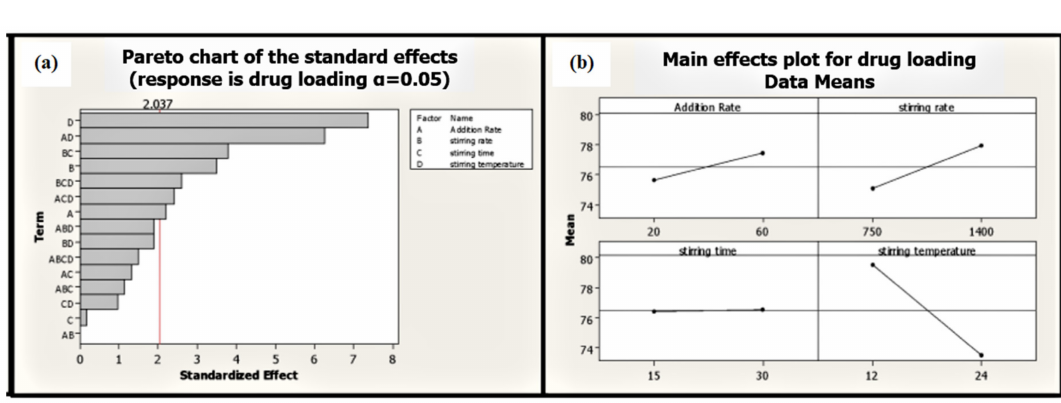
Figure 7. Pareto ( a ) and main e ff ect plot ( b ) of process parameters (PP) on drug loading e ffi ciency. Two-way interactions between process parameters were not significant for the average particle size of phytosome, which was, however, found to have a significant impact on the drug loading of phytosome (addition rate: Stirring temperature; stirring speed: Stirring time) (Figure 8). Slow addition rate and low stirring temperature lead to high drug loading (86.68%) at high stirring speed (Table